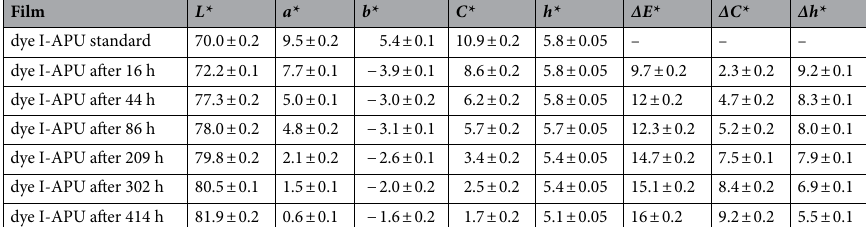
Table 2. The colour properties of the dye I -WB under UV exposure.